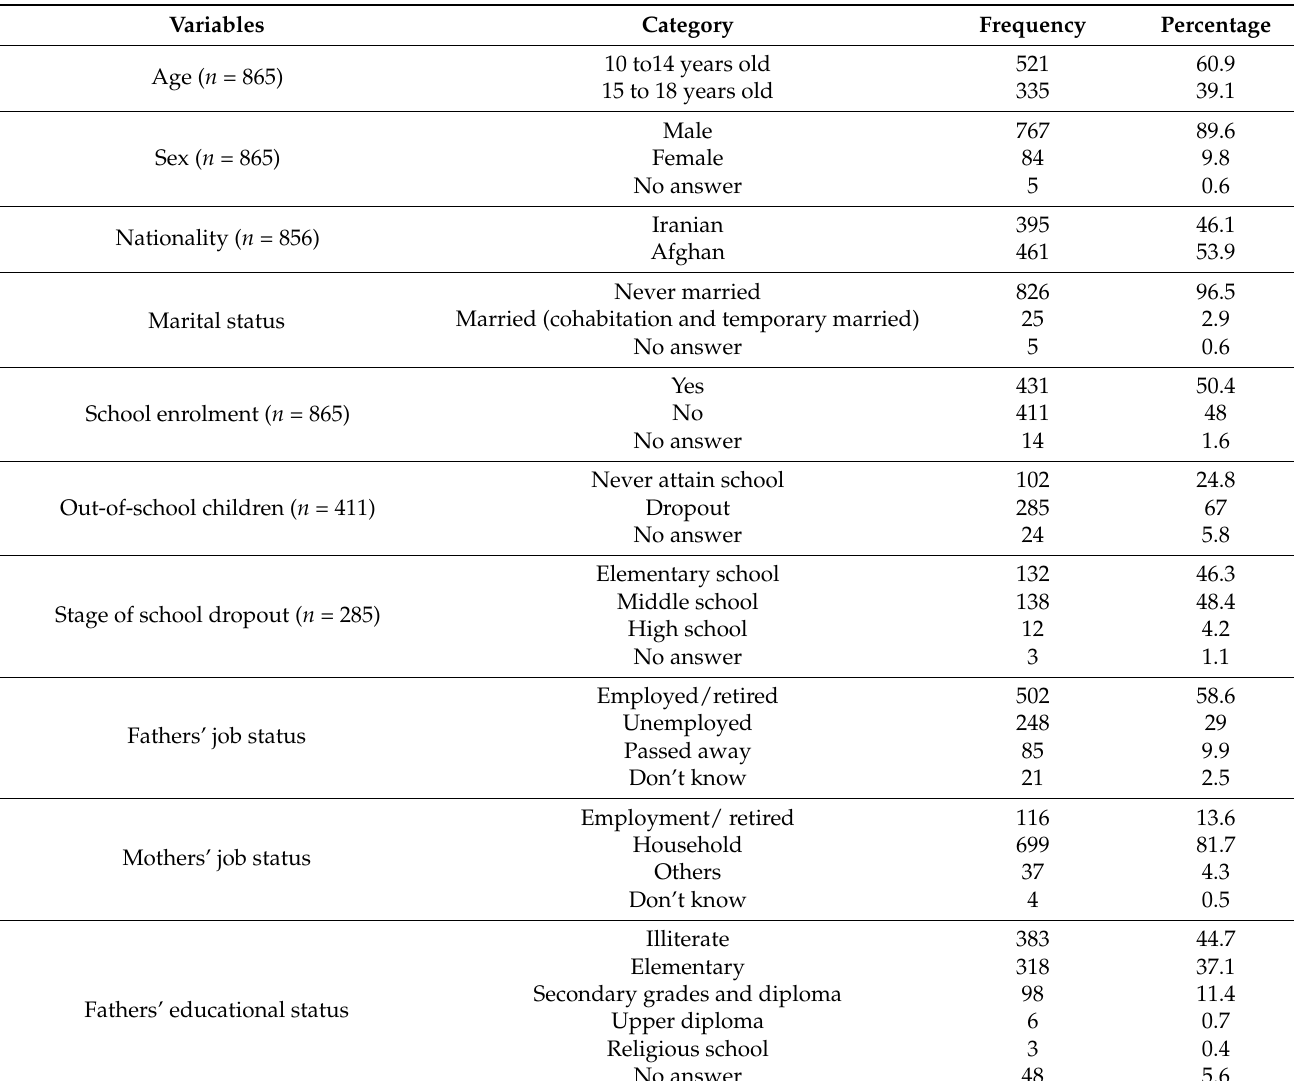
Table 1. Socio-demographic and living condition characteristics of street children and their parents in six provinces of Iran ( n =